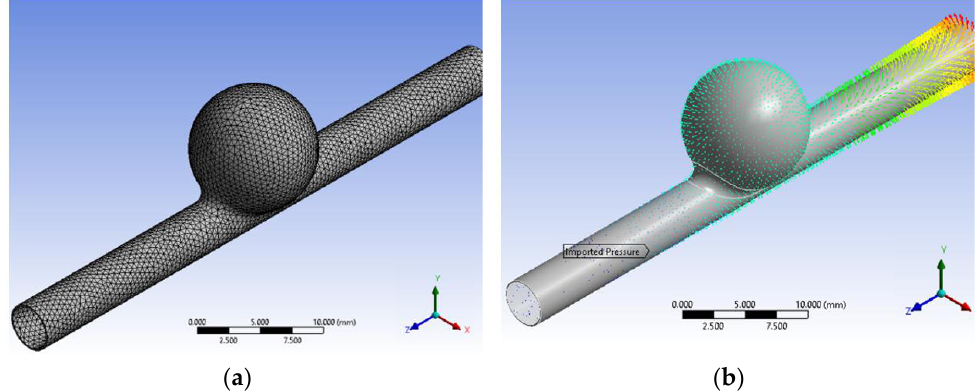
Figure 5. ( a ) Mesh used for the outer part of the channel (wall); ( b ) pressure imported from fluent for the structural static.